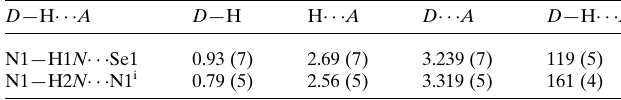
Table 1 Hydrogen-bond geometry (A˚ , (cid:3) ).